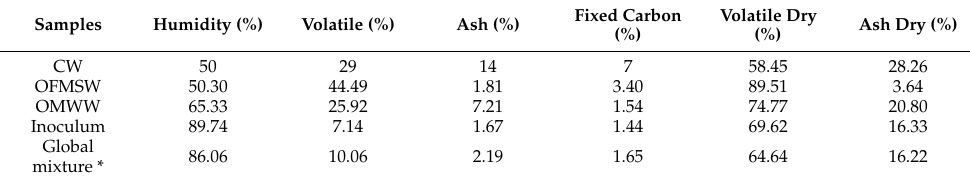
Table 2. Physic-chemical characterization of the substrates and the inoculums (wet basis).